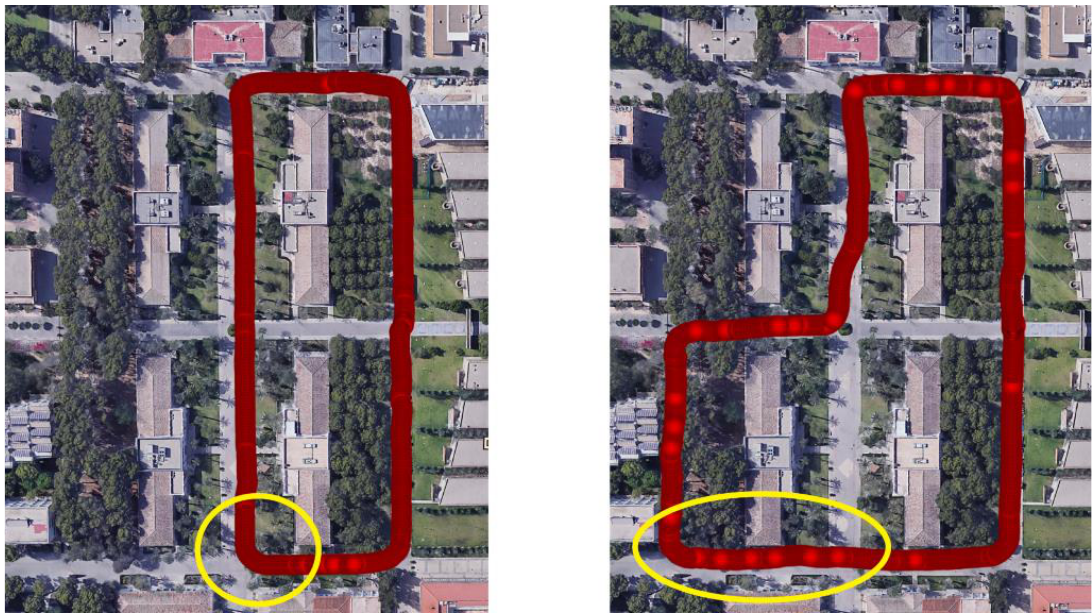
Figure 18. Representation of GNSS fixes in RTK floating point mode, recorded during autonomous navigation. ( right ) Through the path R 3. ( right ) Through the path R 4. In both cases, if the link to the base station is available, the closed loop is completed without problems. Areas marked with yellow circles indicate problem zones for the link to the base